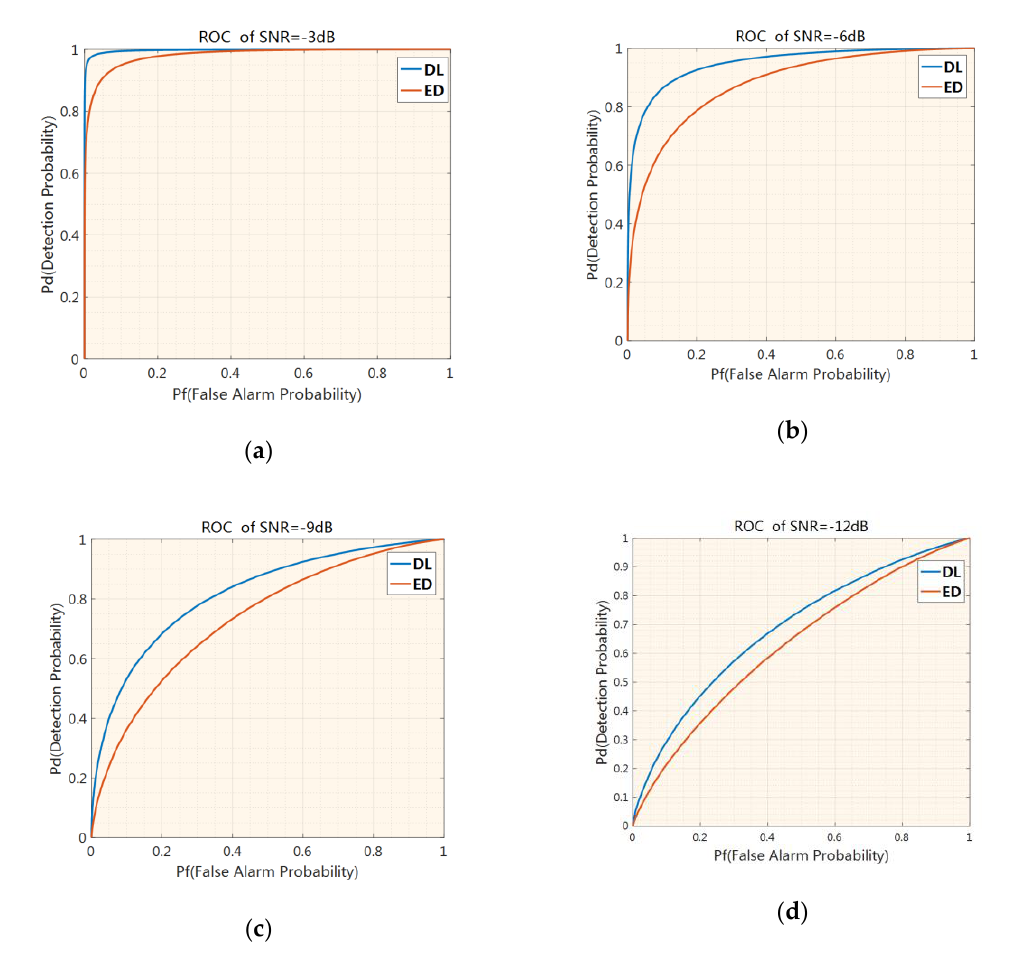
Figure 9. Receiver operating characteristics (ROCs) of the deep-learning-based signal detector versus the energy detector with an SNR of − 3 dB ( a ), − 6 dB ( b ), − 9 dB ( c ), and − 12 dB ( d